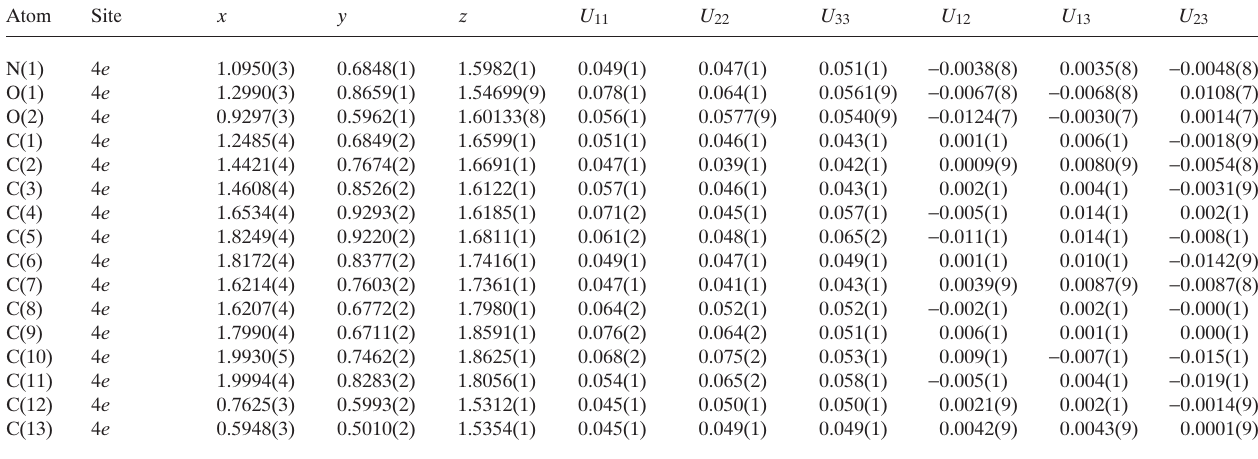
Table 3. Atomic coordinates and displacement parameters (in Å 2 ) .